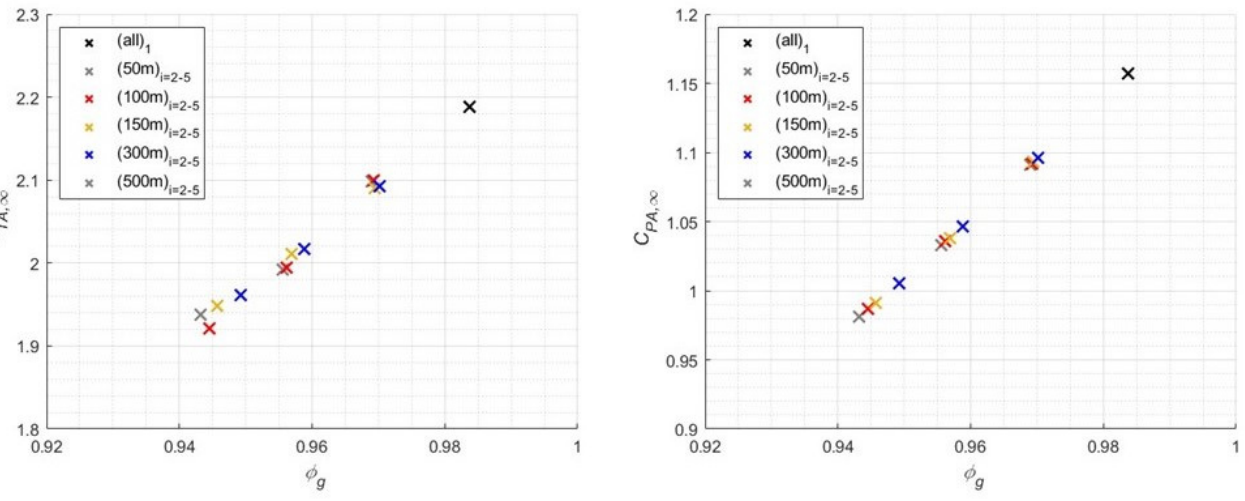
Figure 11. ( Left ) Effect of the array spacing d A on the array thrust coefficient C TA, ∞ vs. global inflow factor ϕ g for a plant of four arrays. ( Right ) Effect of the array spacing d A on the array power coefficient C PA, ∞ vs. global inflow factor ϕ g for a plant of four arrays. The most downstream array is indicated with a black marker. The series of arrays from downstream to upstream are depicted with the same color from right to left.